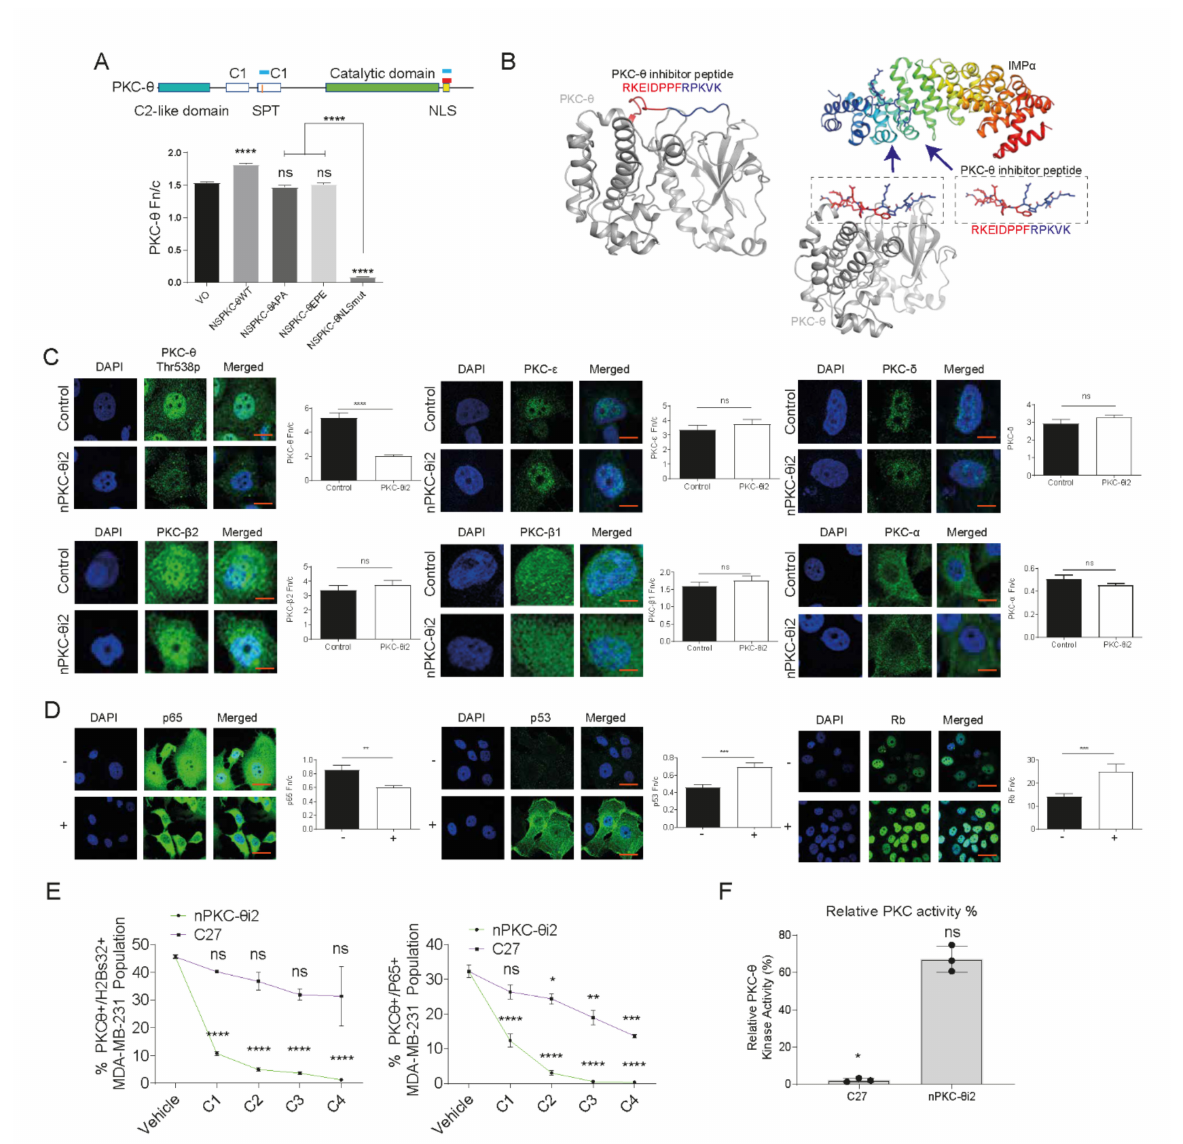
Figure 3. A novel PKC- θ peptide inhibitor specifically inhibits nuclear translocation of PKC- θ without affecting PKC- θ catalytic activity. ( A ) Schematic of PKC- θ depicting its domains including the canonical nuclear localization sequence (NLS) and SPT motifs. Red bars indicate location of peptide inhibitor sequences and blue bars indicate the sequence used to create PKC- θ plasmids. Graphical and schematic representation showing that PKC- θ can be targeted therapeutically. The full-length PKC- θ WT gene sequence and its mutants were used to transfect MCF-7 cells, and the localization of expressed PKC- θ was studied by confocal laser scanning microscopy. Fn/c values for each construct are shown, with significant differences between datasets indicated ( n > 15 for each dataset). ( B ) Structure-guided design of the peptide inhibitor targeting the NLS region of PKC- θ . Left, PyMOL-generated PKC- θ based on the previously determined crystal structure (PDB 2ED) showing the region responsible for nuclear localization in red and blue. Right, structure of the nuclear import adapter IMP α (in ribbon format) bound to a cargo (in stick format) at the major binding site [50], highlighting the strategy for inhibiting nuclear localization of PKC- θ . ( C ) The nuclear localization of PKC- θ and other PKCs (PKC- β 2, PKC- β 1, PKC- δ , and PKC- α ) were examined in the MCF-7 inducible model (IM). Representative images are displayed and the Fn/c shown. Scale bar represents 5 µ m. ( D ) p65, p53, and Rb protein expression was examined in mesenchymal MCF-7 cells stimulated with PKC- θ activators PMA and TGF- β . MCF-7 cells were pretreated for 24 h with vehicle or 25 µ M nPKC- θ